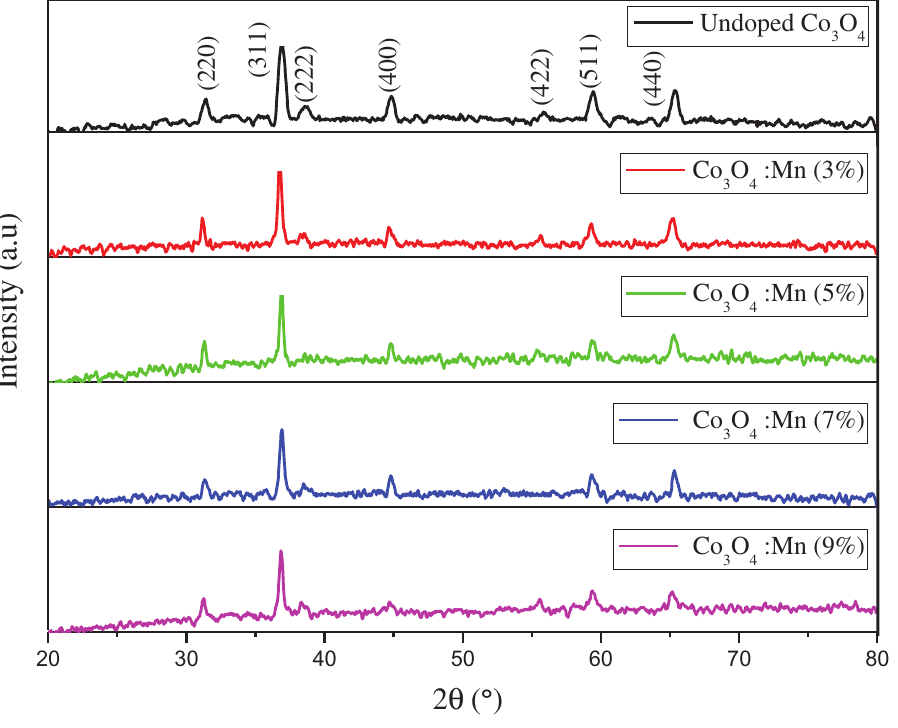
Figure 6: XRD patterns of Mn-doped Co 3 O 4 powders.